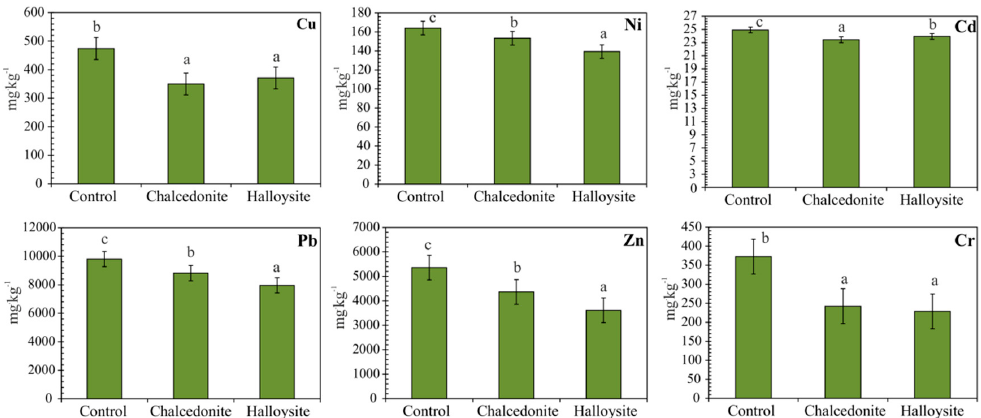
Figure 3. Total potentially toxic elements (PTE) contents in soil after the application of mineral-based amendments. Error bars ± standard error ( n = 3). Different letters denote significant differences between treatments.